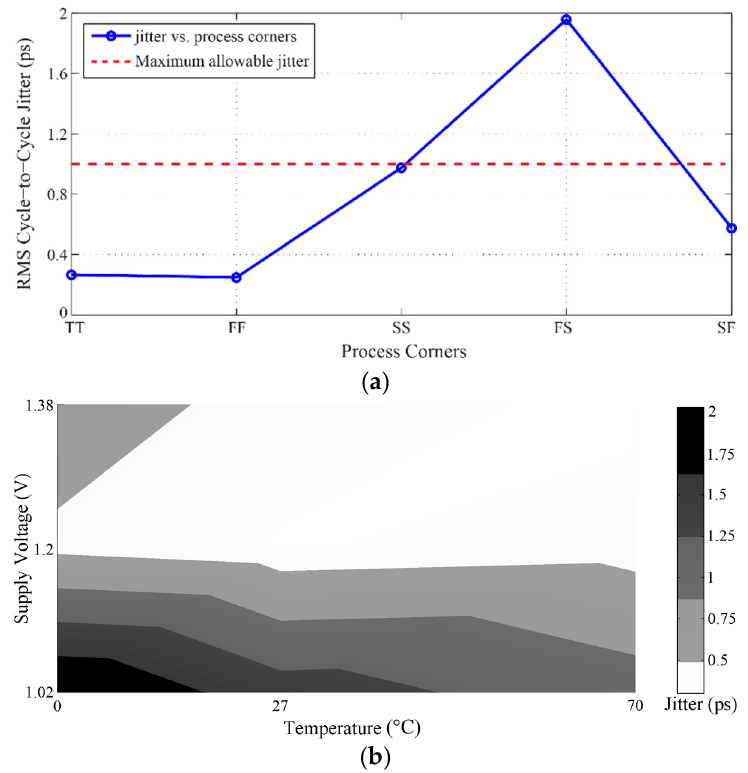
Figure 13. RMS cycle-to-cycle jitter versus: ( a ) process corners; and ( b ) temperature and supply voltage variations.